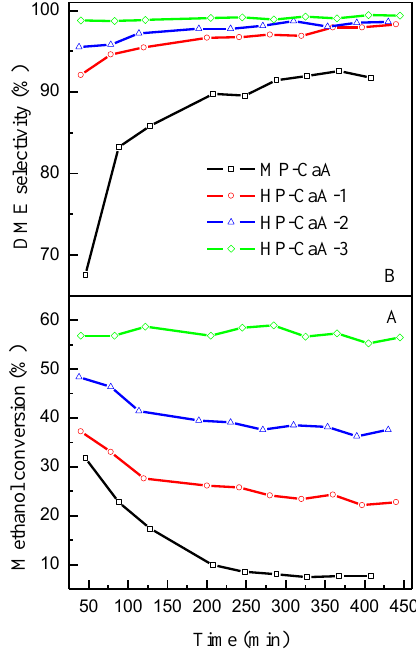
Figure 5. ( A ) Methanol conversion and ( B ) DME selectivity over CaA samples.